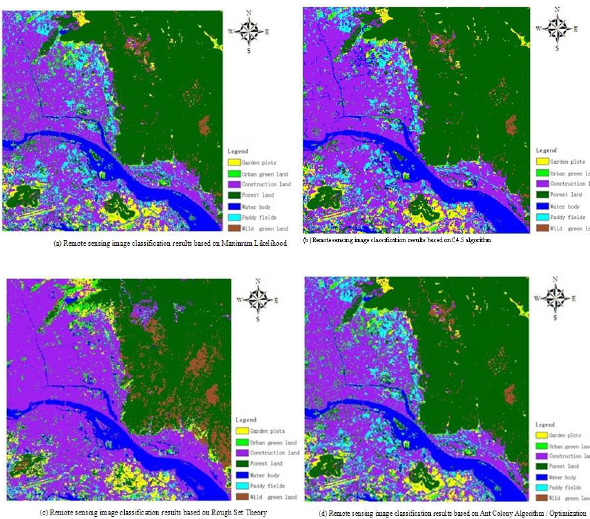
Figure6. Different classification based remote sensing image (a-